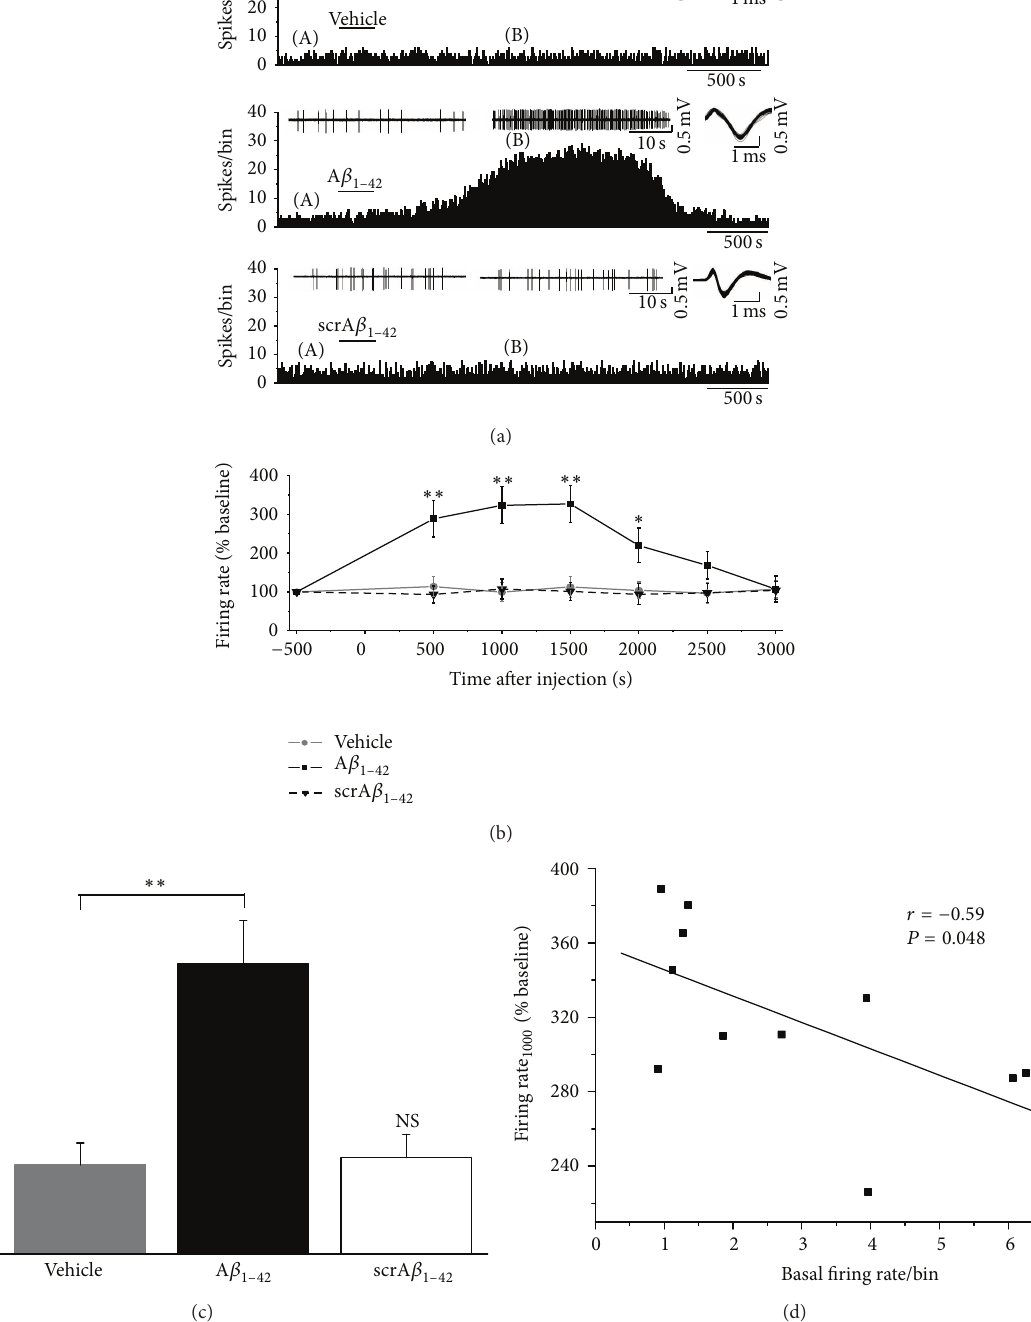
Figure 3: Effects of A 𝛽 1 on the spontaneous firing of EC neurons. (a) Representative traces show the changes of firing activity of EC – 42 (middle), and scrambled A 𝛽 1 (lower). Drugs were applied during the bar. The two neurons after application of vehicle (upper), A 𝛽 1 – 42 – 42 traces in upper panel show firing patterns before (A) and after (B) the application of drugs. The upper right panel of each group displays the waveform of the recorded neuron across each protocol. No obvious change in the spike shape parameters was observed. (b) Time-response , and scrambled A 𝛽 1 ( ∗ 𝑃 < 0.05 , ∗∗ 𝑃 < 0.01 versus curves of the firing rate changes in EC neurons after administration of vehicle, A 𝛽 1 – 42 – 42 , and scrambled A 𝛽 1 on the firing rate of EC baseline values (500 s before injection)). (c) Bar graph summarizing effects of vehicle, A 𝛽 1 – 42 – 42 neurons at 1000 s after local injection ( ∗∗ 𝑃 < 0.01 , NS, no significant difference versus vehicle group). (d) Correlation between the firing tended to enhance the low-rate spontaneous discharge more rate at 1000 s after injection and the basal firing values in EC neurons. A 𝛽 1 – 42